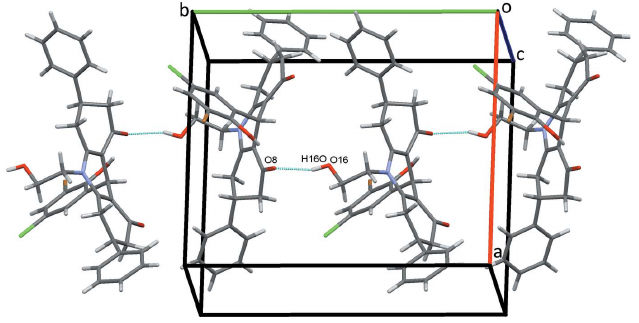
Figure 2 C (9) chains of molecules of (I) along b . In this and subsequent figures, hydrogen bonds are drawn as dashed lines.